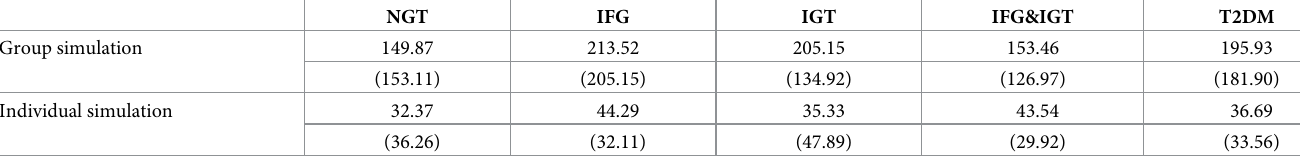
Table 2. Mean (standard deviation) of sum of squared residuals in the model simulations.